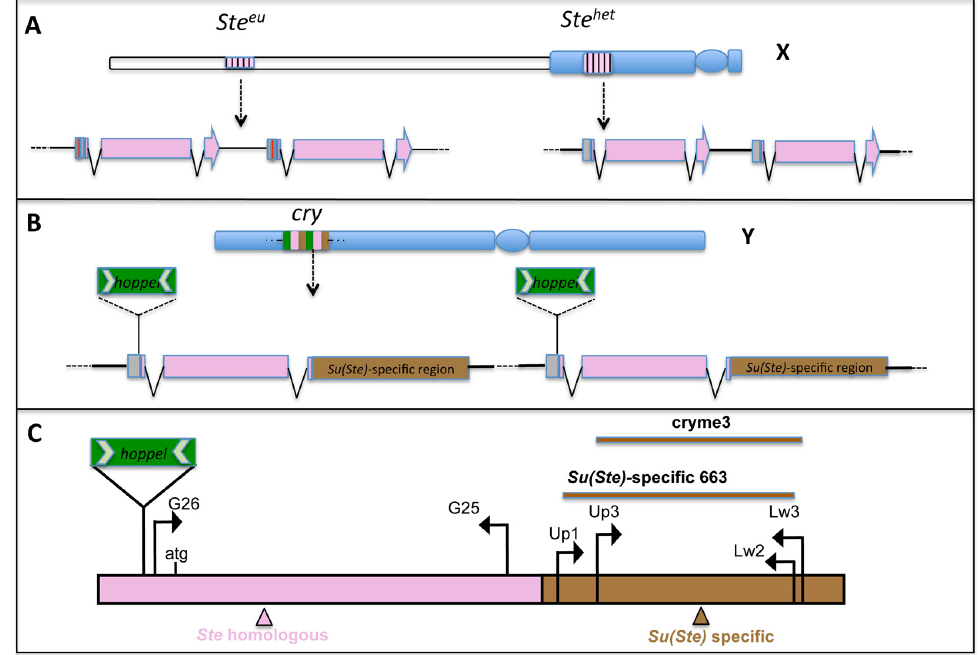
Figure 1. ( A , B ) Schematic representation of the Ste and cry loci on D. melanogaster sexual chromosomes. Heterochromatin is depicted in blue, euchromatin in white. The paralogous sequences of the repeats are depicted by the same color (pink); the green arrow points the insertion site of the Hoppel transposon in the Su(Ste) element; the Su(Ste) -specific region is in brown. ( C ) Position of the primers used to amplify the region-specific probe. All drawings are not to scale.